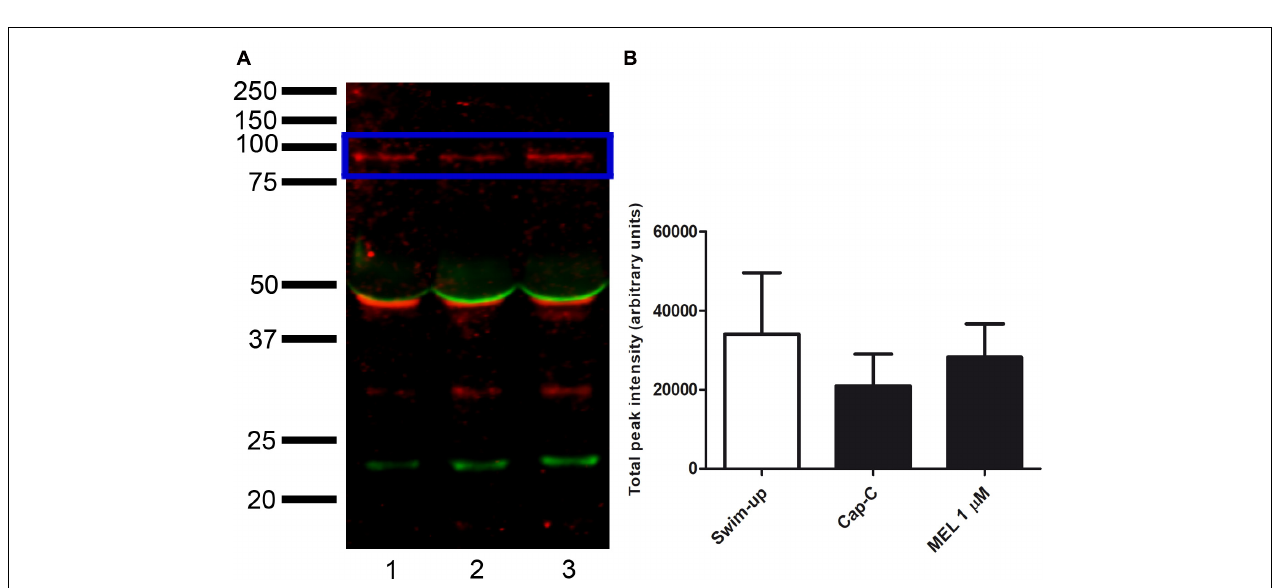
FIGURE 8 | Percentages of the immunotypes for NOX5 in swim-up selected and in vitro capacitated ram spermatozoa with cAMP-elevating agents (Cap-C), and with melatonin (MEL) 1 µ M, GKT163901 (GKT, 1 µ M), calcium ionophore A23187 (ionophore, 1 µ M), and a combination of MEL or GKT with ionophore. Immunotypes are represented as follows: (1) plain white bars (2 + 5) plain gray bars (3 + 4) plain black bars, and (6) horizontal striped bars. Results are shown as mean ± SEM (n = 6 for swim-up, Cap-C and Mel; n = 3 for GKT, ionophore, MEL + ionophore, GKT + ionophore). Different letters indicate statistical differences between treatments ( p < 0.05).